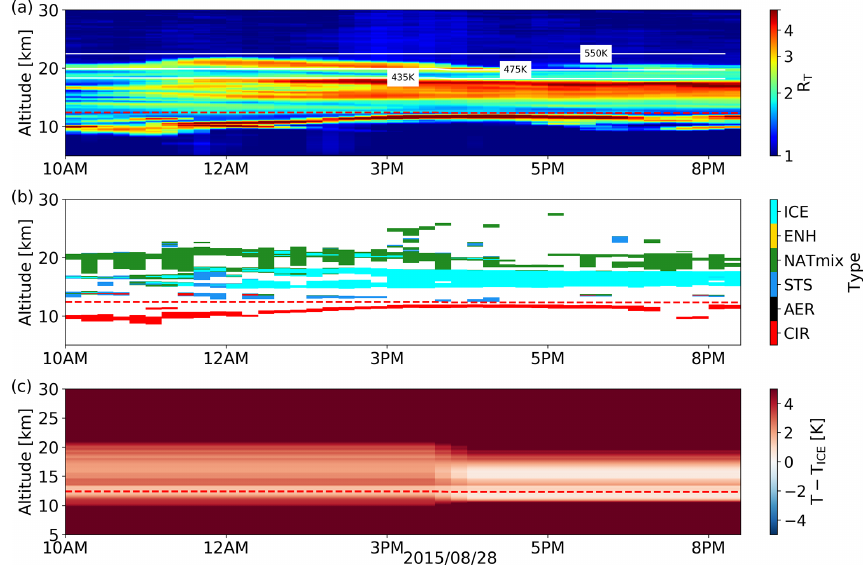
Figure 6. The 532nm backscatter ratio of lidar measurements obtained at DDU on 28 August 2015 (a) . The corresponding PSC types according to P18 classification scheme (b) and ERA5 temperatures at DDU as compared to the ICE formation threshold T ICE , calculated from the MLS H 2 O of the day (c) . The red dashed line indicates the dynamic tropopause computed from ERA5 data.